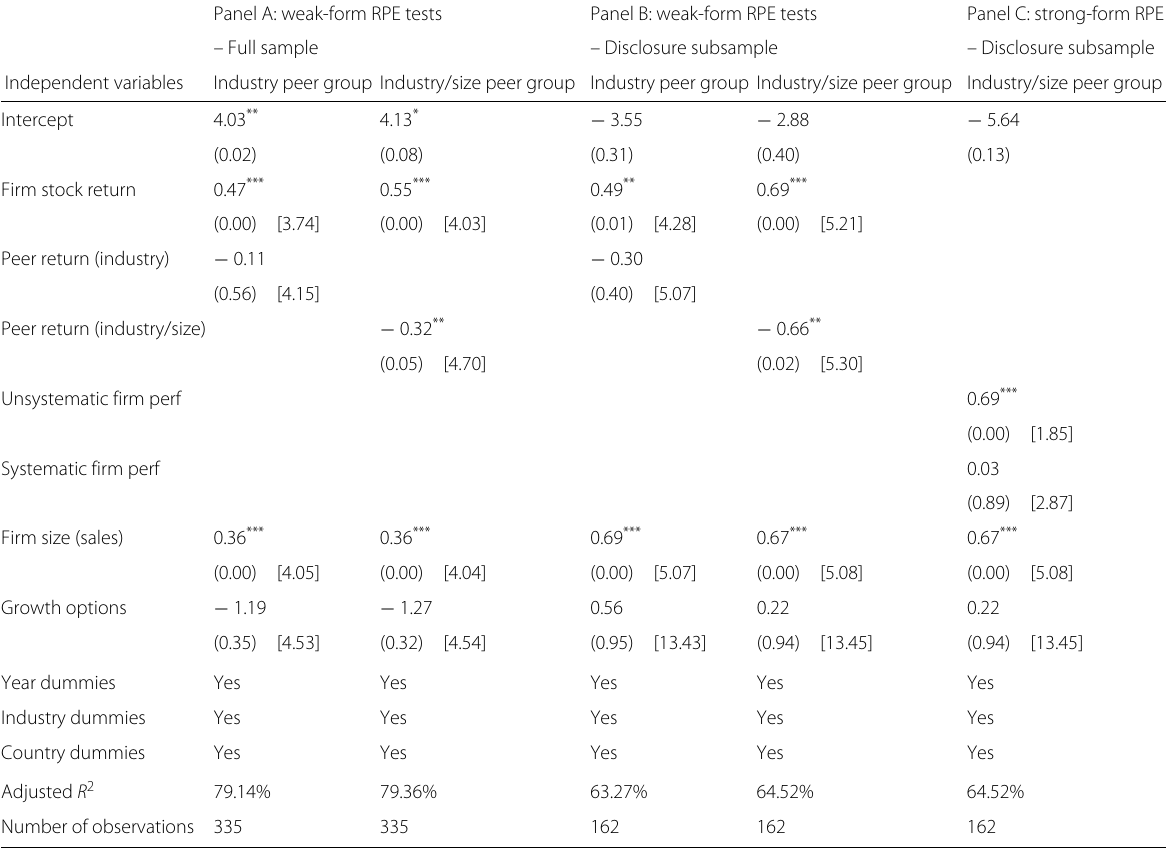
Table 4 Regressions estimating the sensitivity of CEO compensation to RPE Panel A: weak-form RPE tests Panel B: weak-form RPE